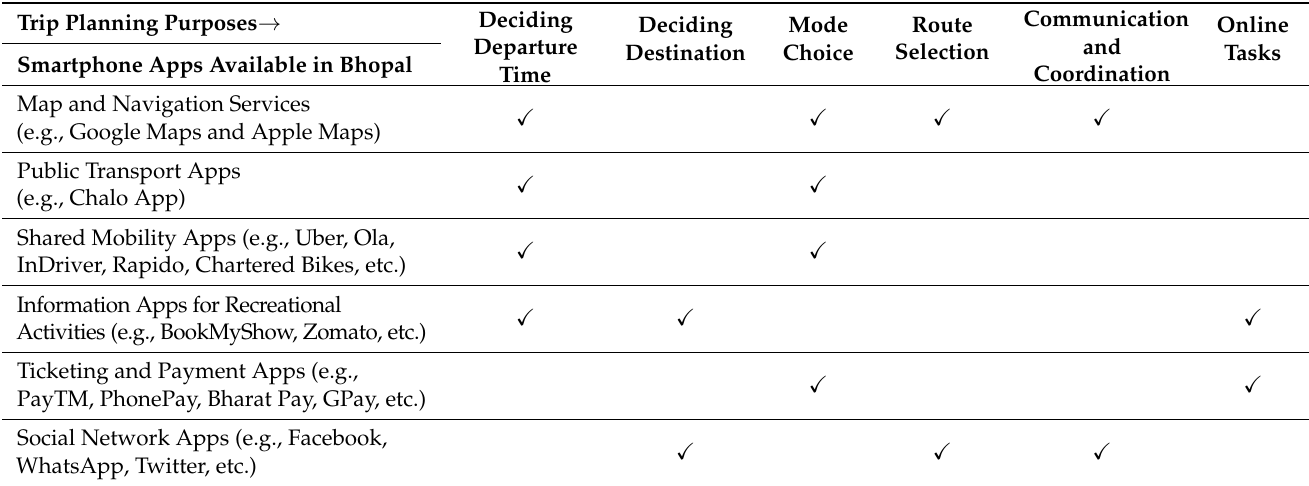
Table 1. Available smartphone apps for trip planning purposes in Bhopal.